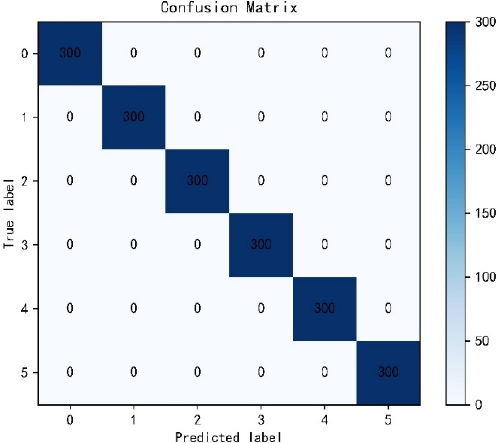
Figure 11. Experiment 1 confusion matrix results.